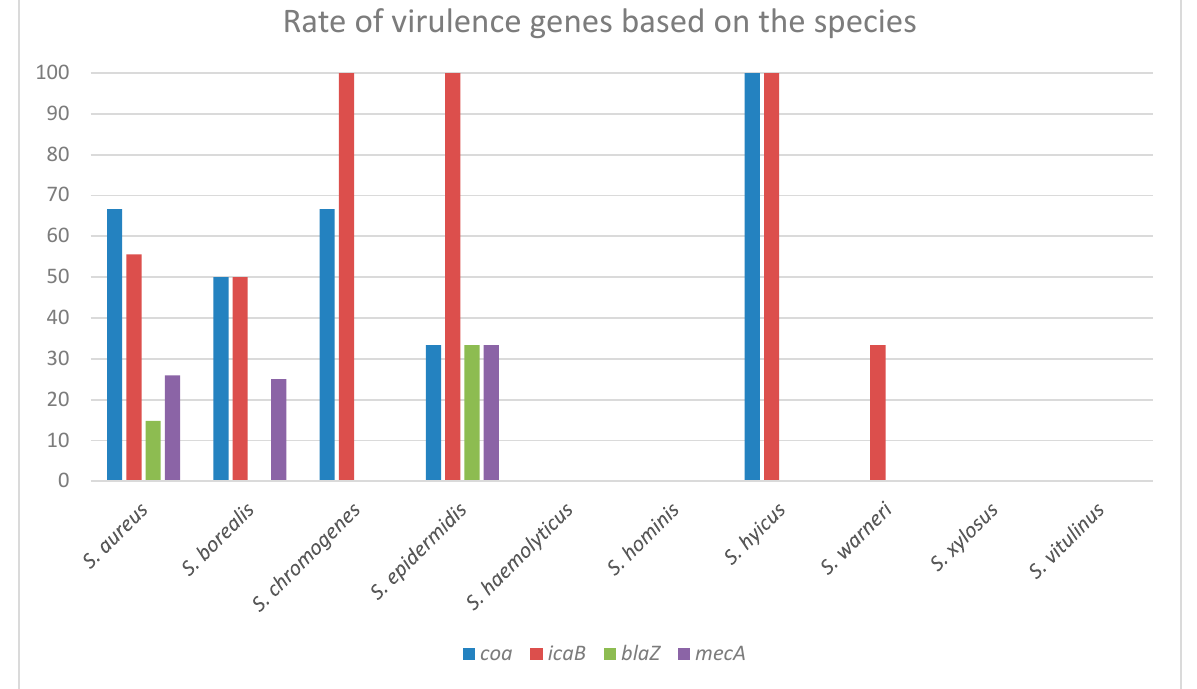
Figure 7. Distribution of virulence genes within the species: This table does not give the general distribution of virulence genes. In this table, information is given about how many of a species detected in the study have which gene. For example, while all S. epidermidis strains were icaB positive, more than 30% of them were positive for coa, mecA , and blaZ . At least six different species in the study contain one or more virulence genes. In the remaining four species, the virulence genes investigated in this study could not be detected.